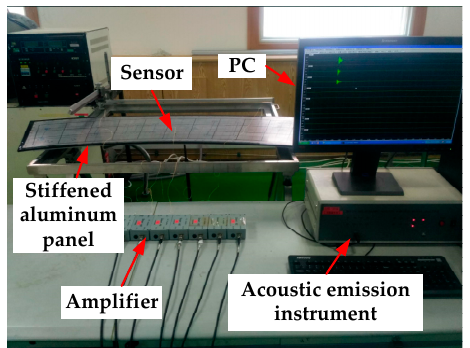
Figure 13. Experimental system.